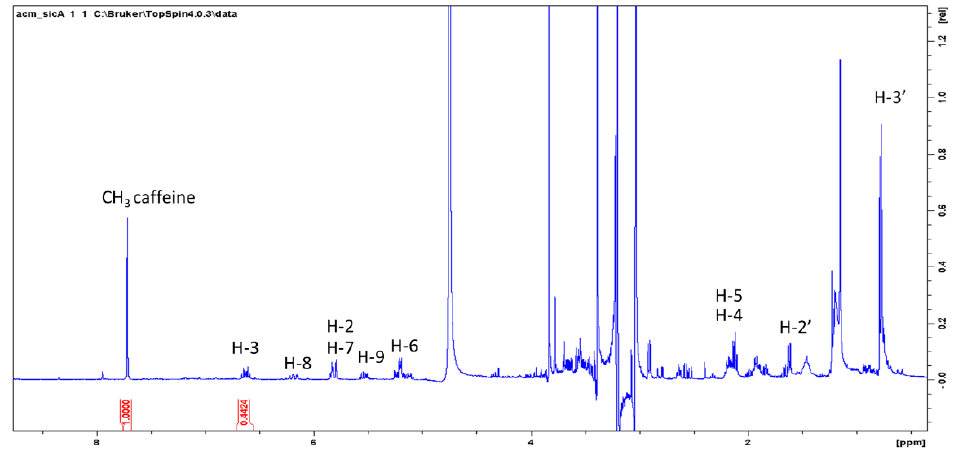
Figure 4. 1 H NMR of in commercial sample of A. oleracea with internal standard caffeine .